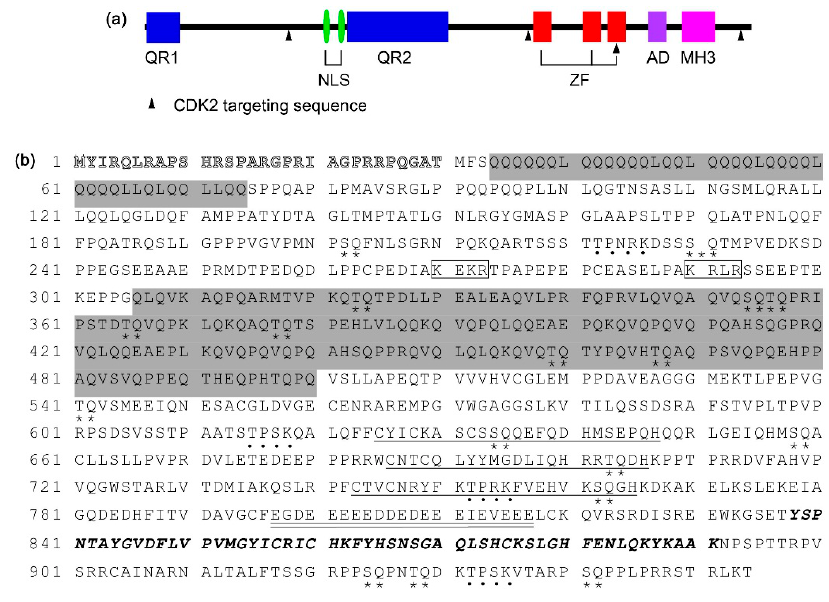
Figure 1. Schematic structure and sequence alignment of human CIZ1 protein. ( a ) Schematic illustration of CIZ1 protein. The glutamine rich region (QR1 and QR2), nuclear localizing signal (NLS), zinc finger domain (ZF), MH3 domain (MH3), acid domain (AD), and CDK2 targeting sequence are indicated in the diagram; and the ( b ) amino acid sequence of CIZ1 protein (Accession No. NP_001244904.1). The first 30 amino acid (aa) residues are only predicted but have not been validated [19]. The two glutamine-rich domains are shaded with grey. The three zinc finger motifs are underlined and the acidic domain is double-underlined. The MH3 domain is in bold and italic. The two nuclear localizing signals are boxed. The predicted CDK2 and PIKK phosphorylation sites are indicated by dots and asterisks, respectively.